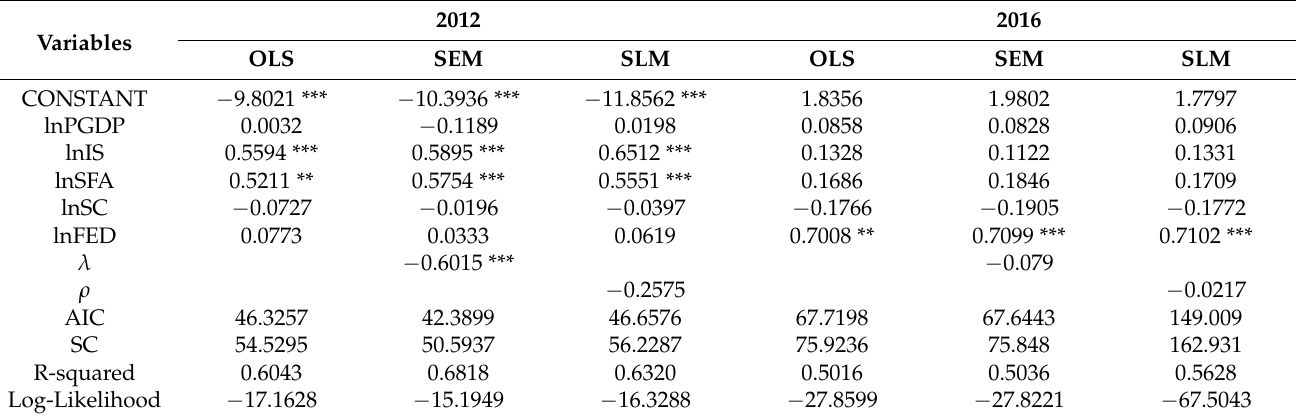
Table 4. Parameter estimation results of econometric models in the Guangdong